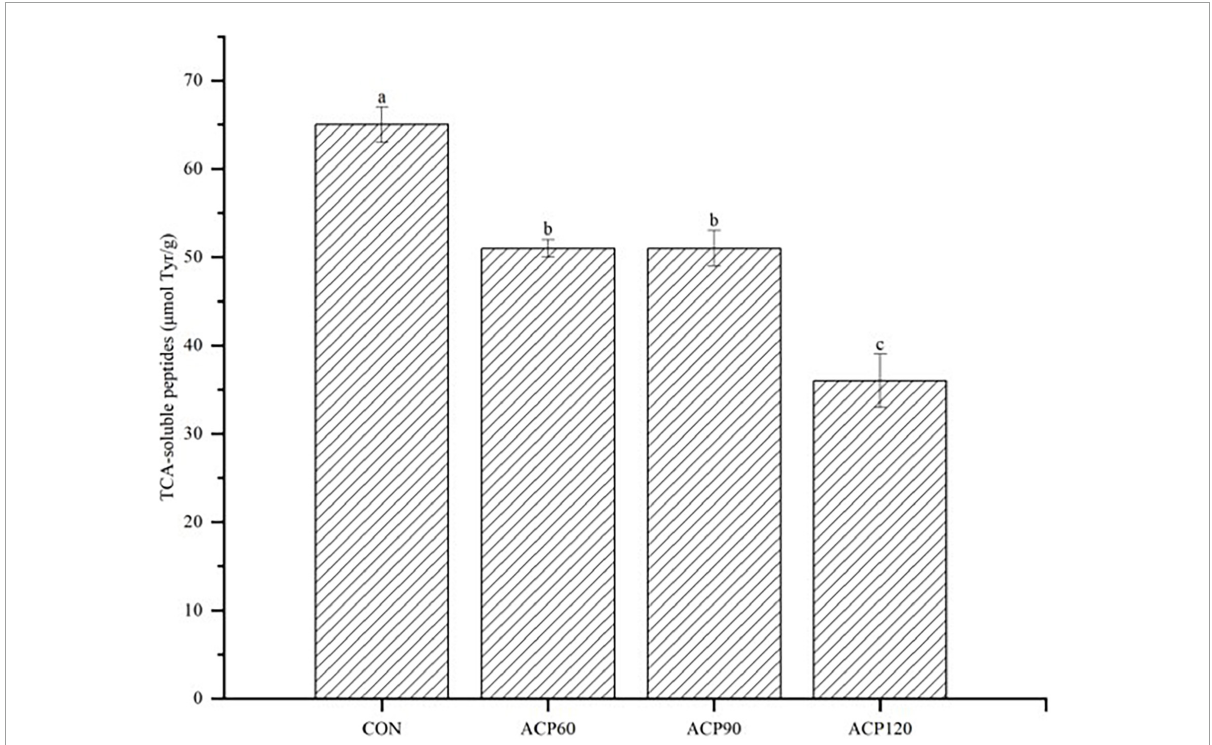
FIGURE8 The analysis of TCA-soluble peptides content of surimi gels subjected to different treatment times. The different lowercase letters represent significant differences ( p < 0.05). (CON, surimi gels without ACP treatment; ACP60, surimi gels treated with ACP for 60 s; ACP90, surimi gels treated with ACP for 90 s; ACP120, surimi gels treated with ACP for 120